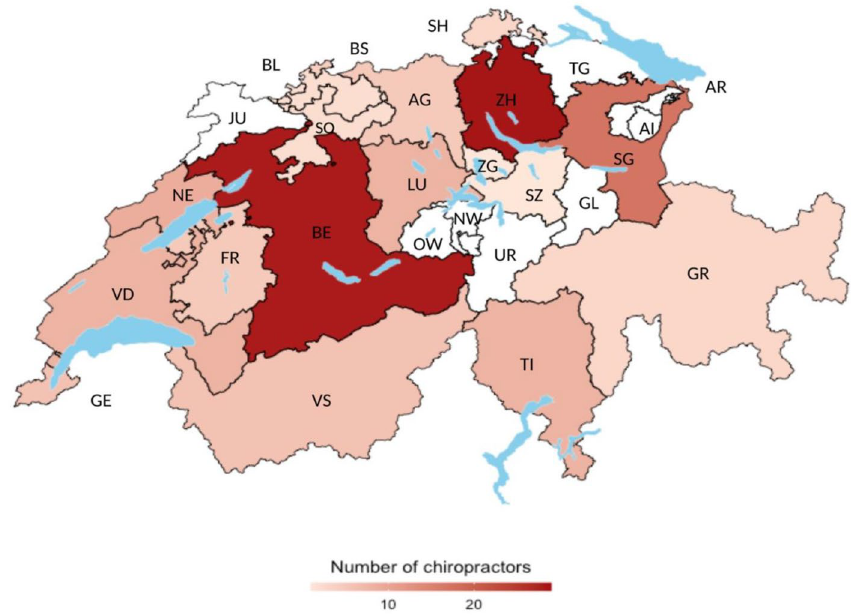
GR Graubünden, JU Jura, LU Luzern, NE Neuchâtel, NW Nidwalden, OW Obwalden, SG St. Gallen, SH Schaffhausen, SO Solothurn, SZ Schwyz, TG Thurgau, TI Ticino, UR Uri, VD Vaud, VS Valais, ZG Zug, ZH Zurich. Source of map: “RSwissMaps” package, R (Version 4.2.0, https:// www.R- proje ct.